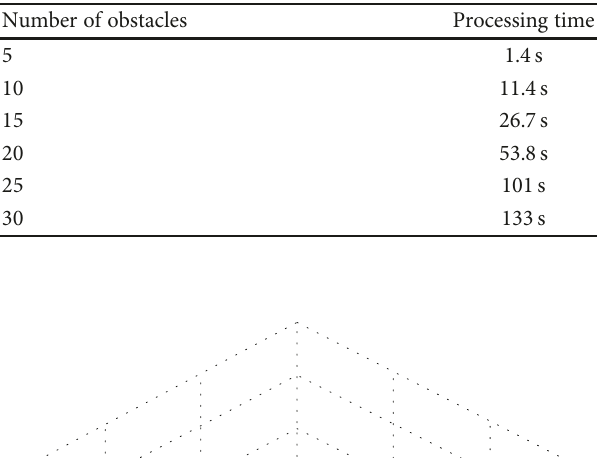
Table 2: Environment parameters.